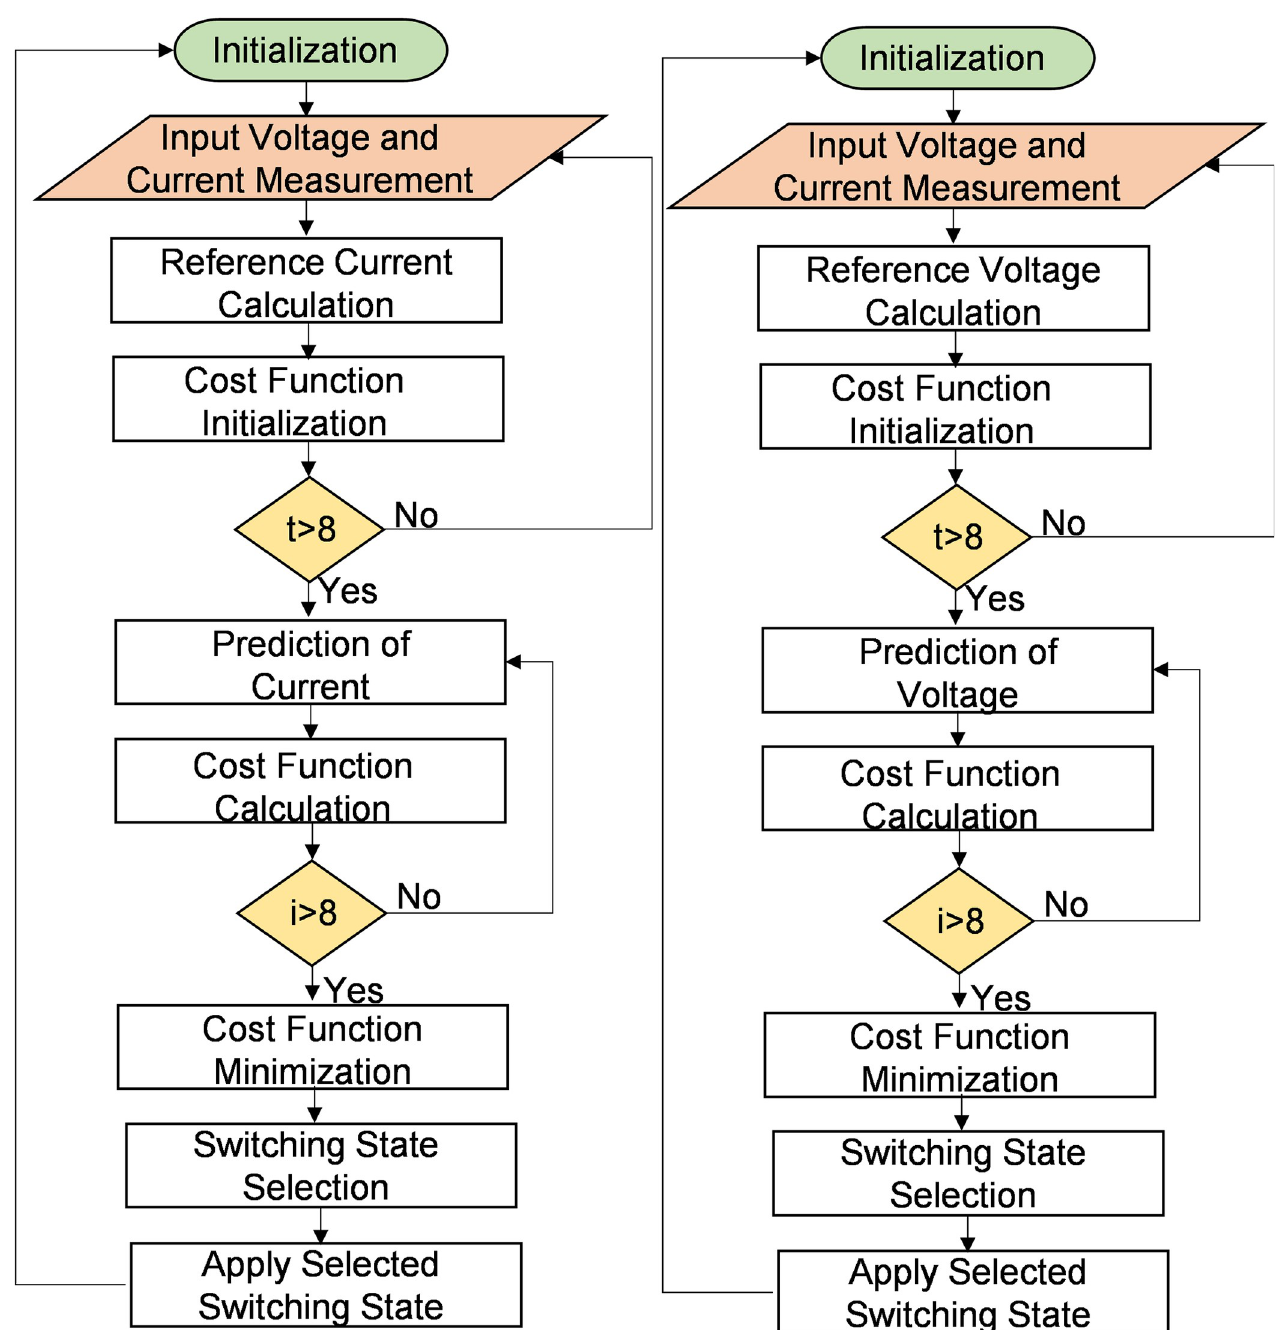
Fig 4. (a) GFE DG control algorithm; (b) GFM DG control algorithm.